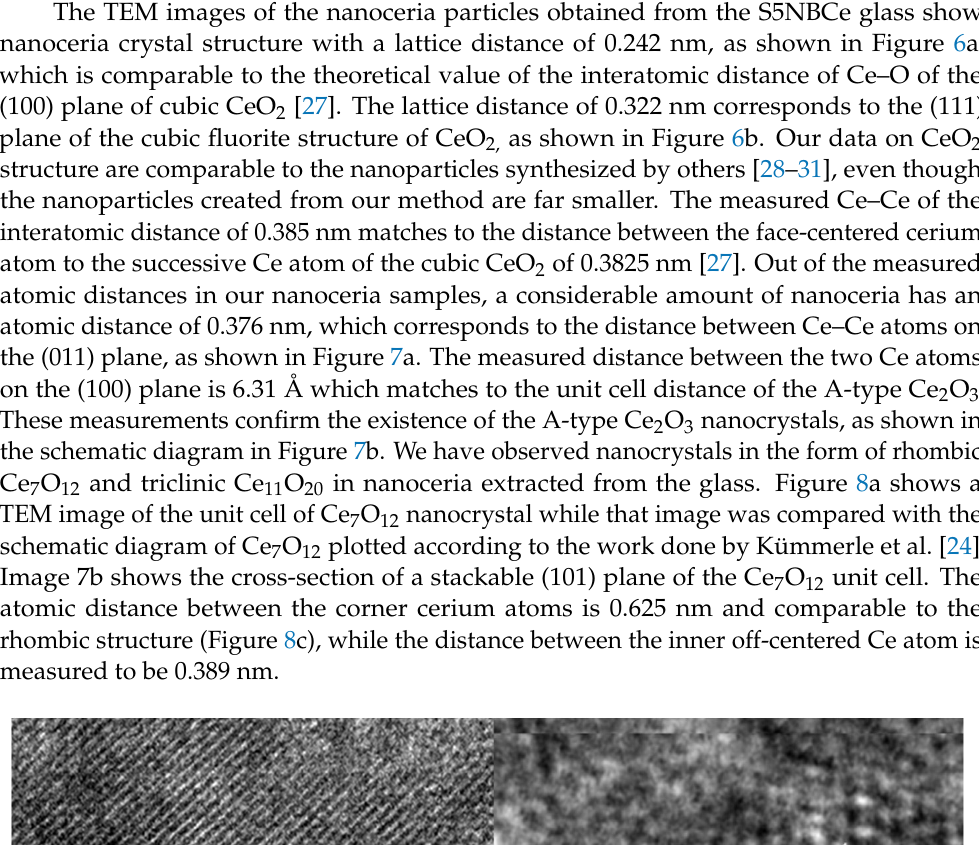
Figure 5. Schematic diagram of ( a ) cubic fluorite structure of CeO 2 , ( b ) hexagonal Ce 2 O 3 structure, ( c ) rhombohedral Ce 7 O 12 , and ( d ) cubic body-centered structure of Ce 11 O 20 larger cerium atoms are shown in green, while the smaller oxygen atoms are shown in red.